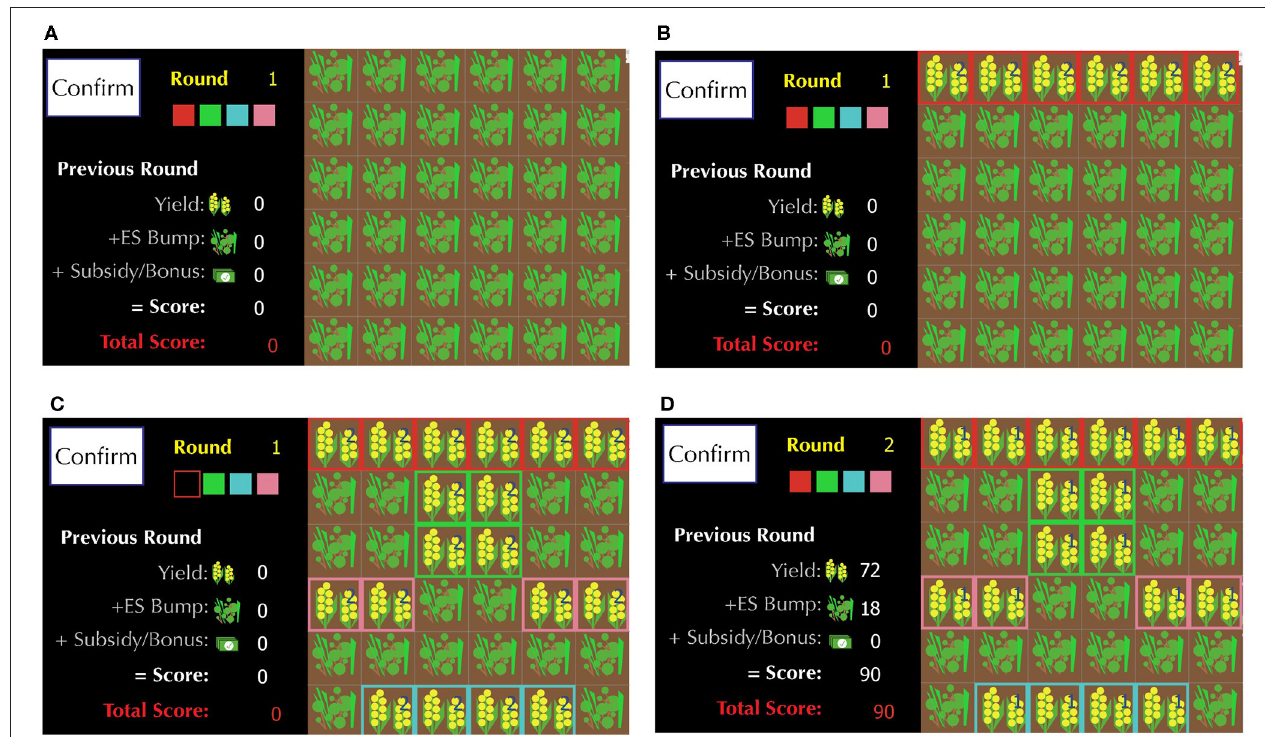
FIGURE 2 | Visual representation of the farming landscape in the common right treatments, players are colour coded, (A) game screen of the active player at the start of the game; the player can farm any cells in the landscape (up to nine); (B) the active player farmed six cells (the red coloured cells in the first row of the grid); (C) game screen of the active player after all four players have made decisions at the end of round 1, the decisions taken by the other players are also visible, the green, blue and pink cells are farmed by the three other players; (D) game screen of the active player at the start of round 2, the scores of the active player in previous round is shown in the left-hand side of the panel. TABLE 1 | Game